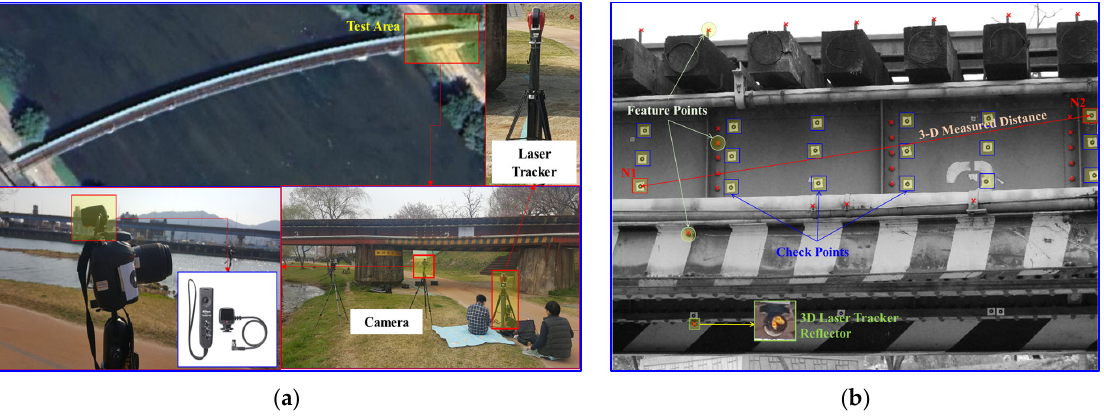
Figure 4. ( a ) Test span of the curviform railway bridge in Suncheon of South Korea, two ‐ camera setup with a remote controller and two receivers, laser tracker; ( b ) layout of 26 feature points and 18 target checkpoints on the test span bridge, N1 and N2 points used to adjust the scale of the ROPs, the zoomed ‐ in view of a laser reflector in the lower left part of the bridge.